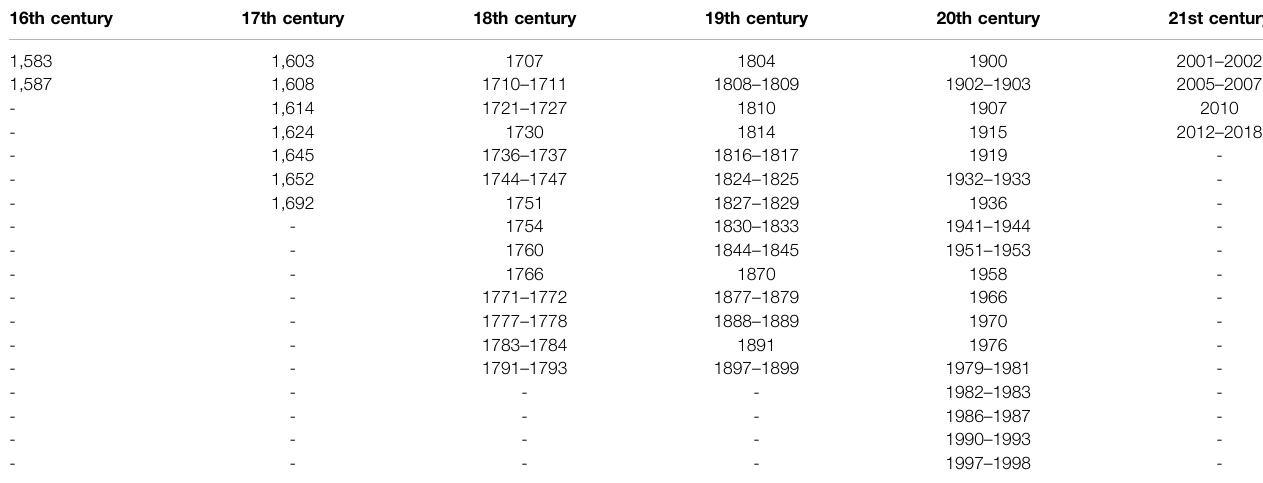
TABLE 1 | History of drought periods in the Northeastern Region of Brazil.